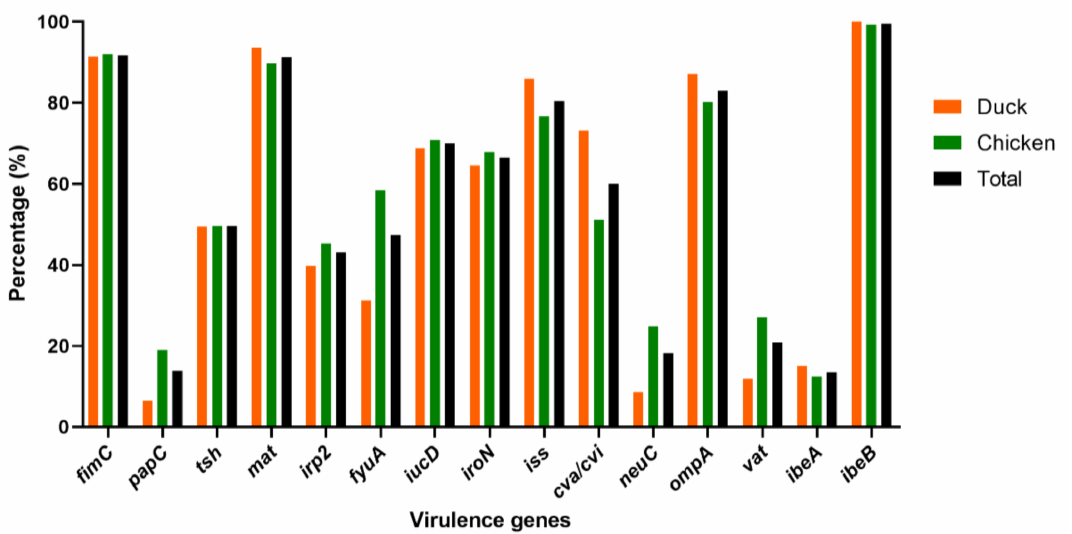
Figure 3. Distribution of virulence genes in 230 APEC isolates from chickens ( n = 137) and ducks ( n = 93). Bar charts show the frequency rates of each virulence gene in APEC isolated from chicken (green), duck (orange) and total